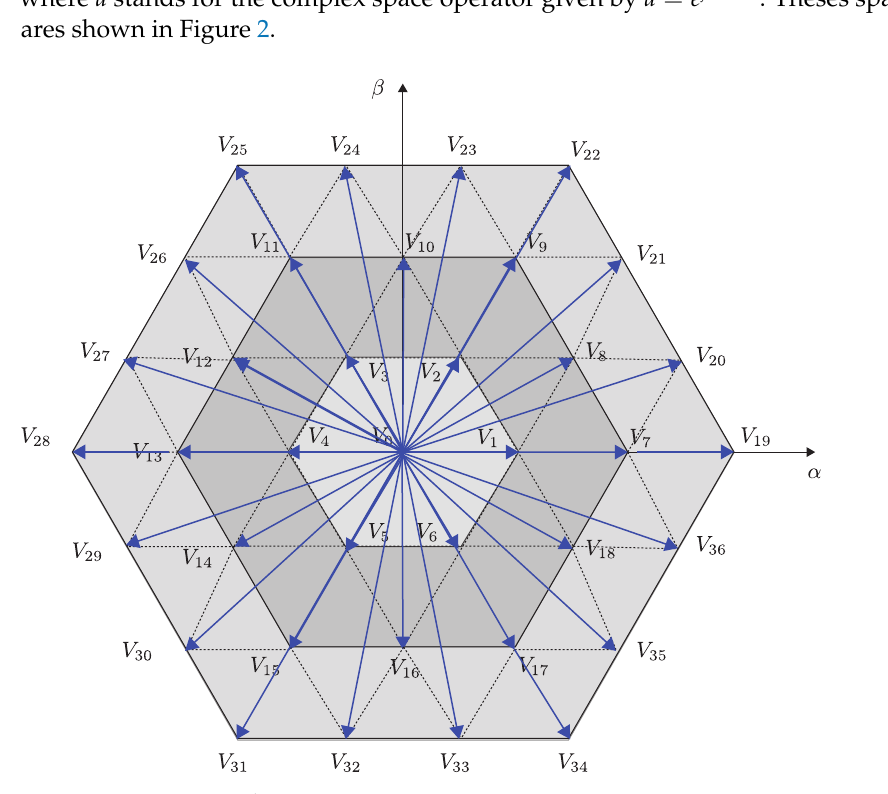
Figure 2. 4L-QNC topology space